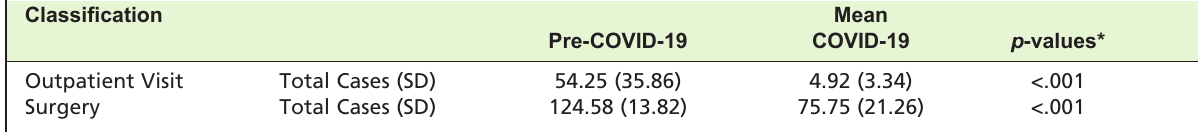
Table II: Total outpatient visit and surgery procedure in pre-COVID-19 and COVID-19 period